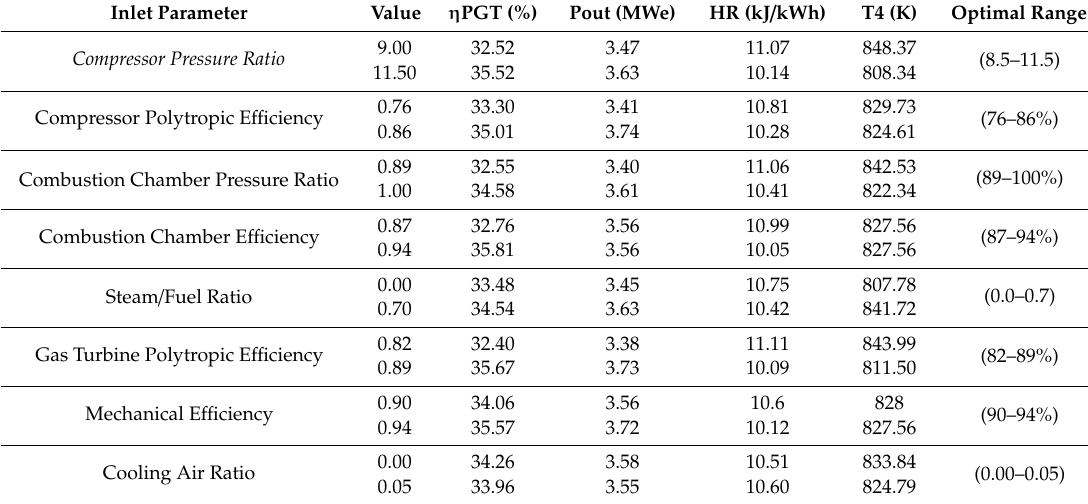
A summary results table for Figures 6–13, with determined optimal ranges of the analysed